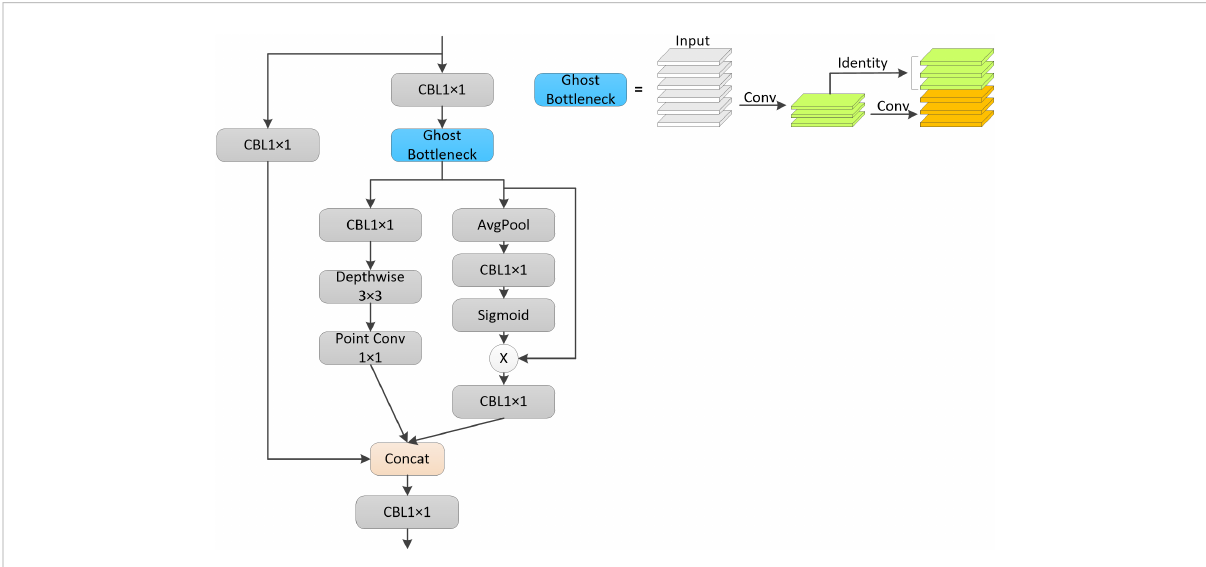
FIGURE 2 Improvement of the CSP